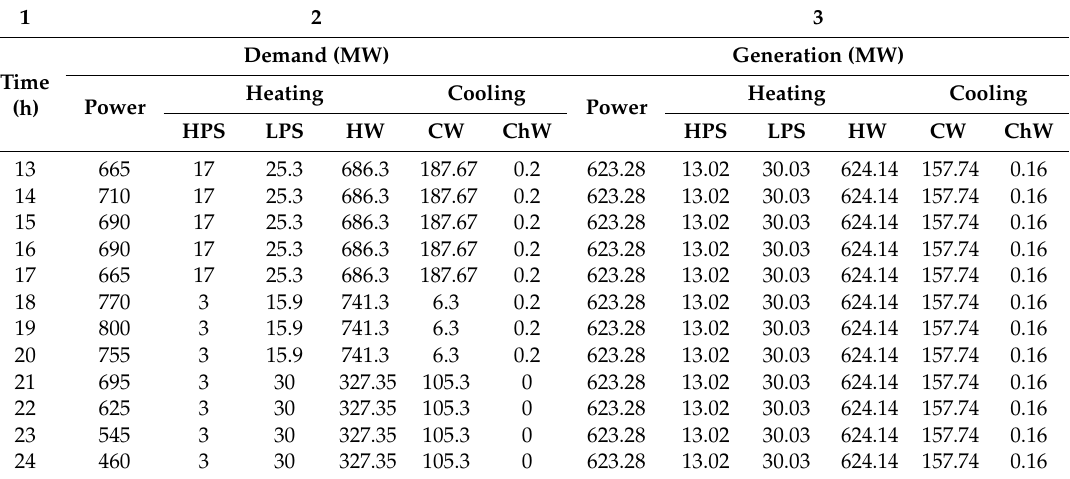
Table A10. TriGenSCA after iteration from time 13 to 24 h.